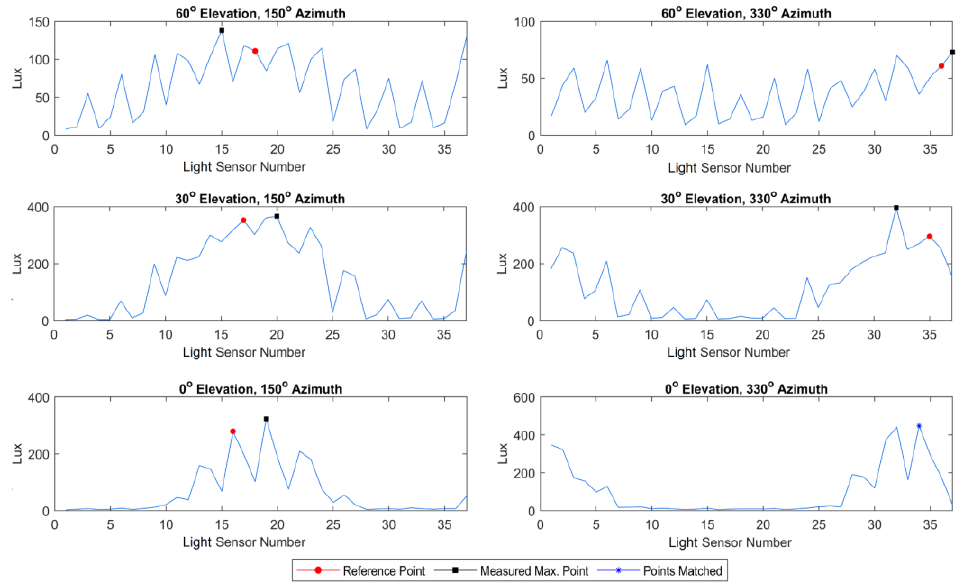
Figure 8. Selected samples of measurement results for Experiment 1. Here, the measured data were shown as raw data values without any processing. Elevation and azimuth angles, at which the light source is located, were accepted as ref- erence points. Measurement results yield the highest outputs mostly around reference